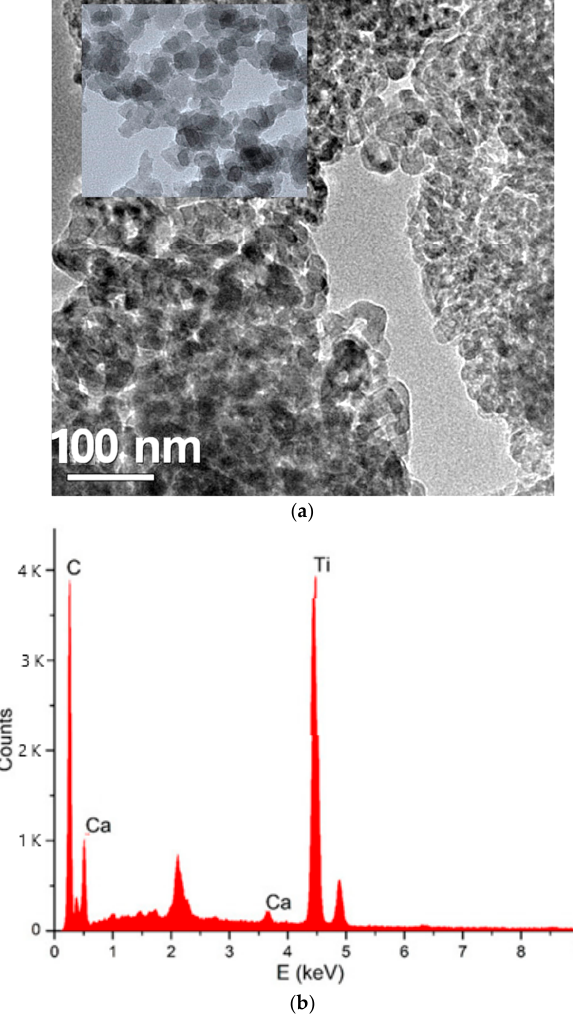
Figure 2. TEM ( a ) and EDx ( b ) analysis of HTiO 2 particle anchoring on the surface of AC/SiO 2 .